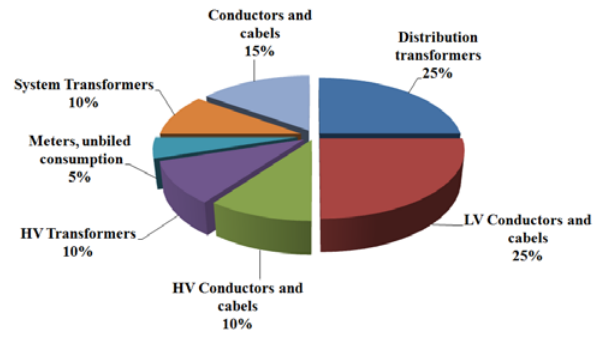
Figure 1. “Power transmission and distribution loss components in European Networks”.